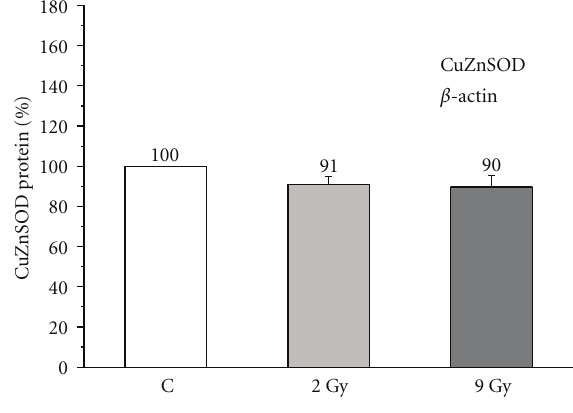
Figure 6: Relative level of CuZnSOD protein in blood cells non- irradiated (C) and irradiated with 2Gy and 9Gy of γ -radiation, in healthy women above 58 years. Relative values are expressed as percent of value found in the nonirradiated control group, which is considered as 100% (student’s paired t